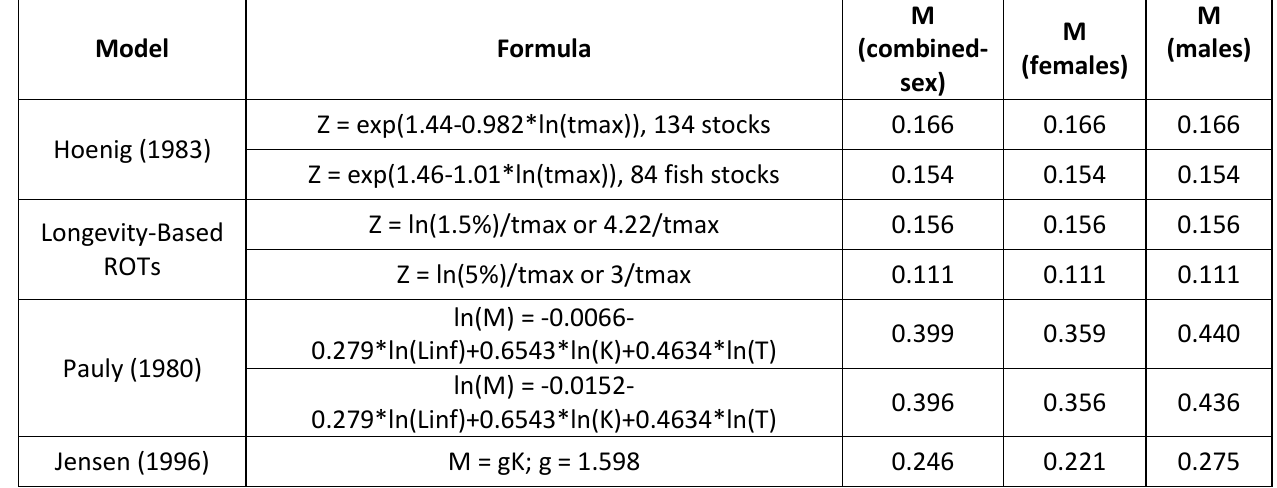
Table 9. Models and estimates of age-invariant instantaneous natural mortality rates for horseshoe